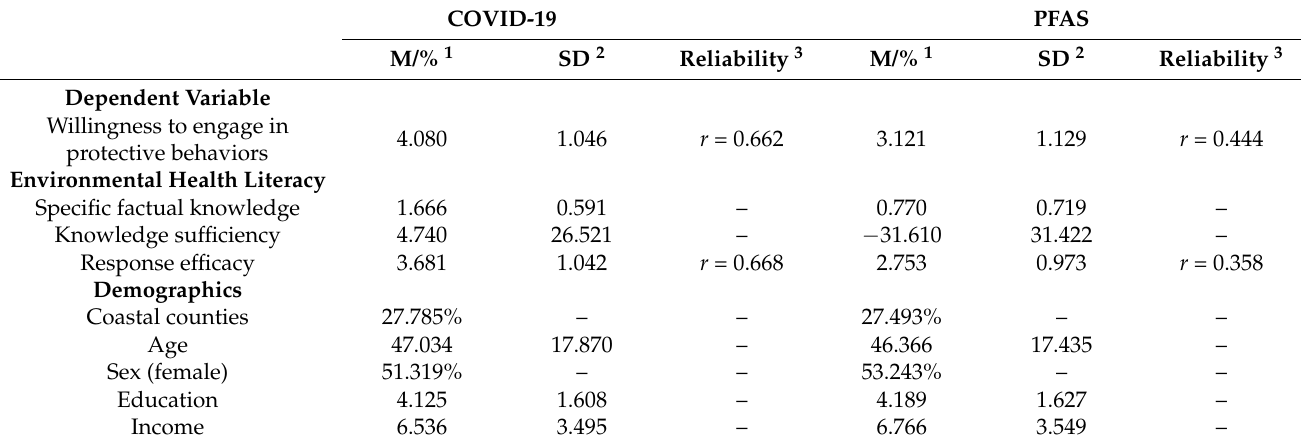
Table A3. Univariate descriptive statistics for independent and dependent